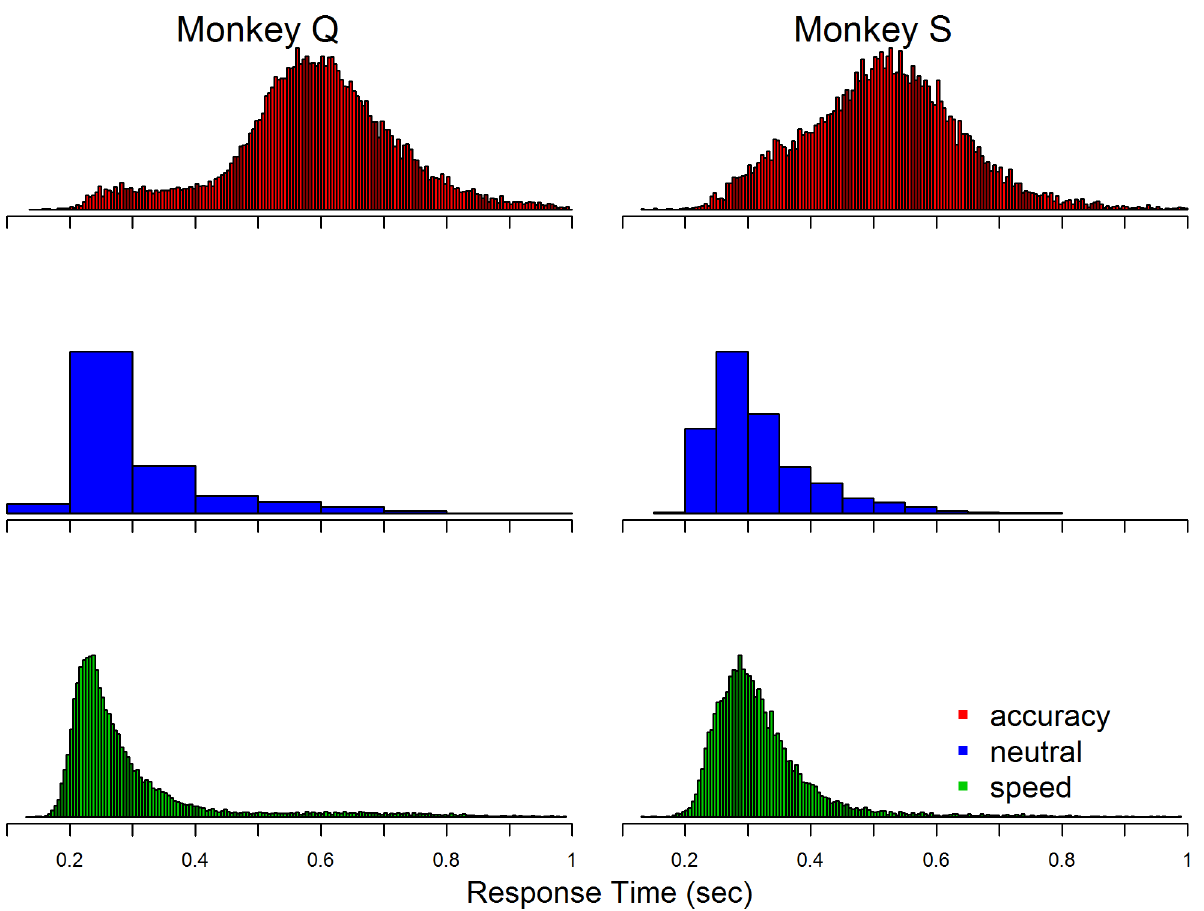
Figure 1. Response time histograms, plotted separately for speed, neutral and accuracy conditions, for Monkeys Q and S. The neutral-emphasis condition uses wider histogram bins because there were many fewer data from that condition. Histograms are collapsed over correct and incorrect responses, but see Figure 2 for more information.